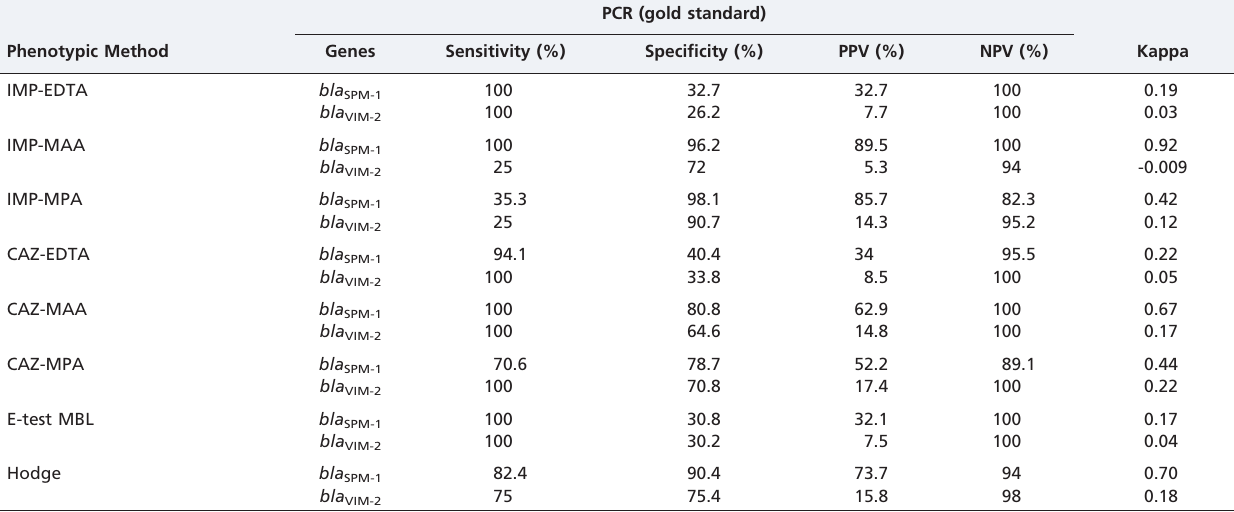
Table 2 – Performance of phenotypic methods for detecting SPM-1 and VIM-2 enzymes.